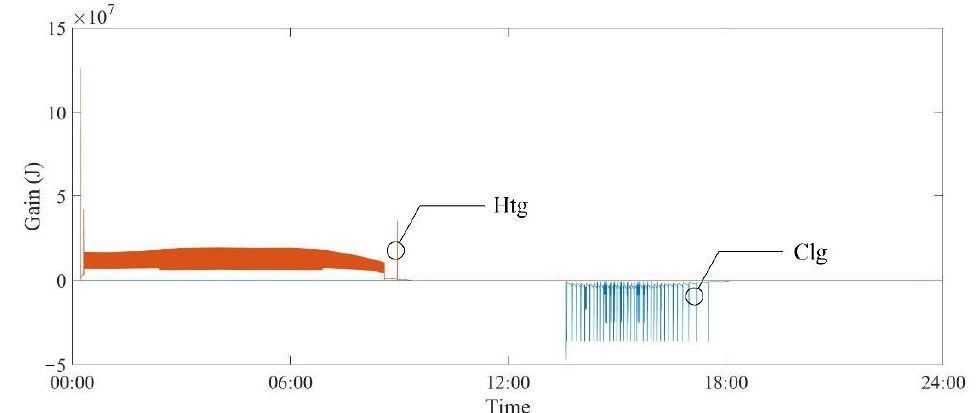
Figure 10. Energy consumption controlled by FC.